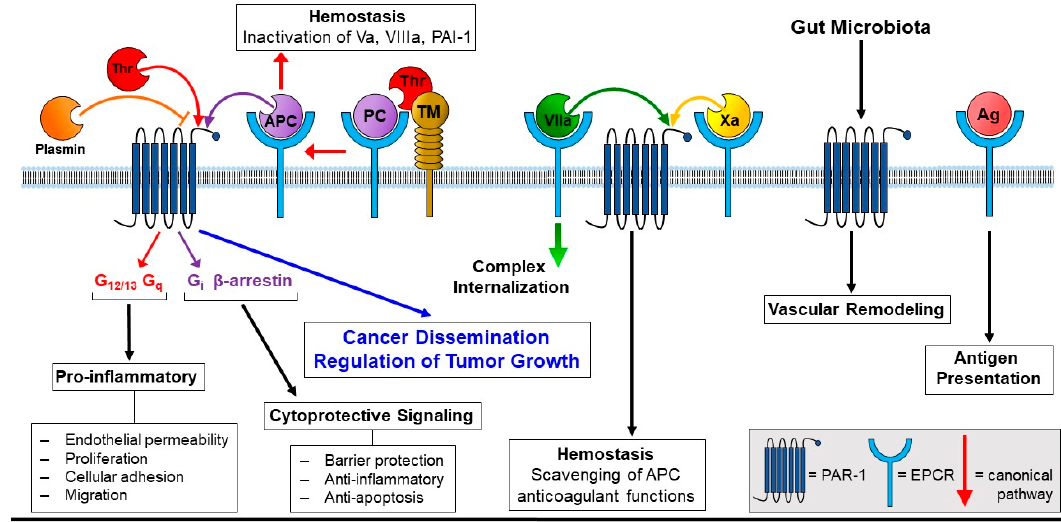
Figure 1. Moonlighting functions of the endothelial protein C receptor (EPCR). In addition to its canonical role as a cofactor in the anticoagulant protein C pathway, localized to the vascular endothelium, EPCR is also expressed on other cell types and ascribed new roles in antigen presentation, epithelial permeability regulation, cancer cell evasion, anti-apoptotic effects, and anti-inflammatory protease-activated receptor-1 (PAR-1) signaling. Abbreviations: Thr, thrombin; PC, protein C; APC, activated protein C; Va, Vllla, Vlla, Xa, active coagulation factors; Ag, antigen; TM, thrombomodulin; PAI-1, plasminogen activator inhibitor-1.